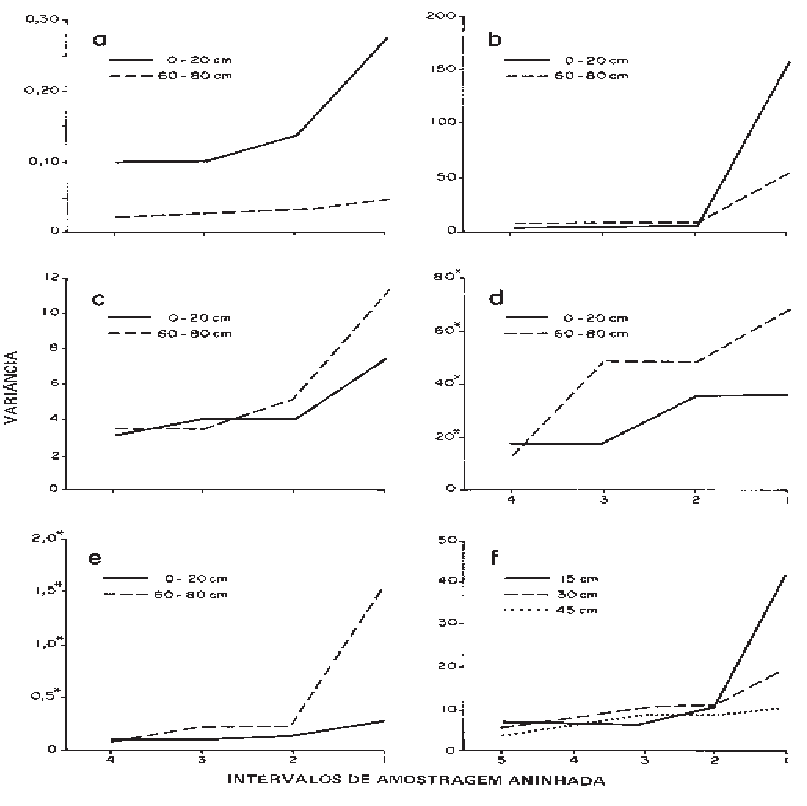
Figura 3. Variogramas com os valores da variância das características dos solos estudados: (a) pH, (b) argila, (c) matiz da cor, (d) valor da cor, (e) croma da cor e (f) resistência à